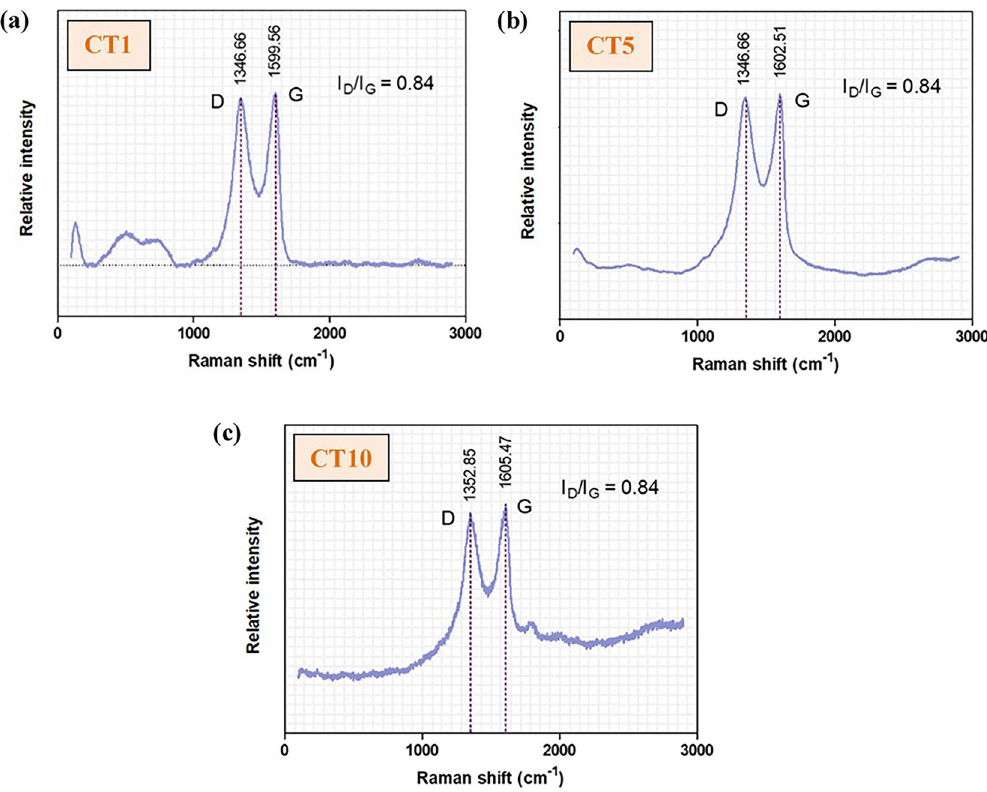
Figure 1. Raman spectroscopy of the GO/AgNPs coated NiTi alloy samples coated using 3 coating times: ( a ) CT1 = 1 min, ( b ) CT5 = 5 min, and ( c ) CT10 = 10